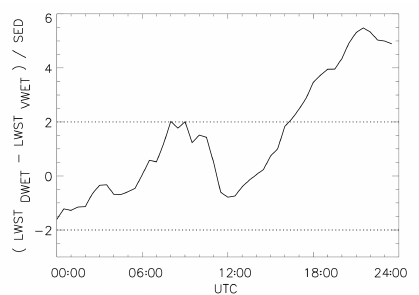
Figure 11. Diurnal behaviour of the difference in mean values of LWST in the DWET and VWET cases, normalised by the standard error of the difference, SED; see Eq. (2). The dotted lines show ± 2 standard deviations for this statistic. It may be seen that the value climbs above 2 at later times, indicating the significance of the dif- ference in the means